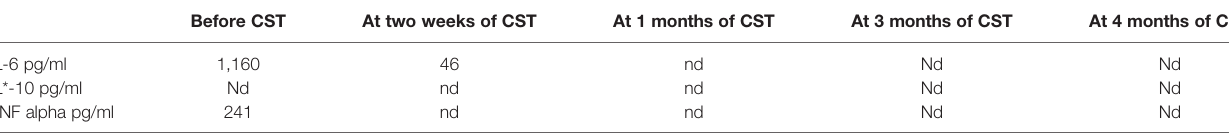
TABLE 2 | CSF cytokines measurement before and after corticosteroid salvage therapy (CST). Before CST At two weeks of CST At 1 months of